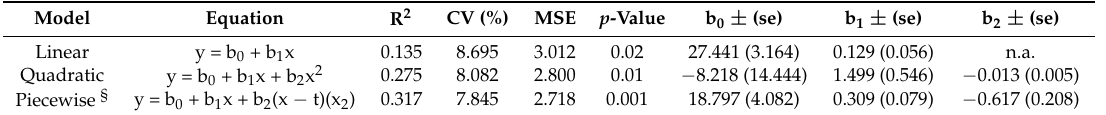
Figure 5. Linear, quadratic, and two-segment piecewise linear regression models for oil content on seed weight of jatropha seed from three elite accessions. INIAP Portoviejo Research Station, Ecuador. Table 3. Parameter estimates for linear, quadratic, and two-segment piecewise linear regression equations of oil content (y) on seed weight (x) of jatropha seed samples from three elite accessions. INIAP Portoviejo Research Station, Ecuador.